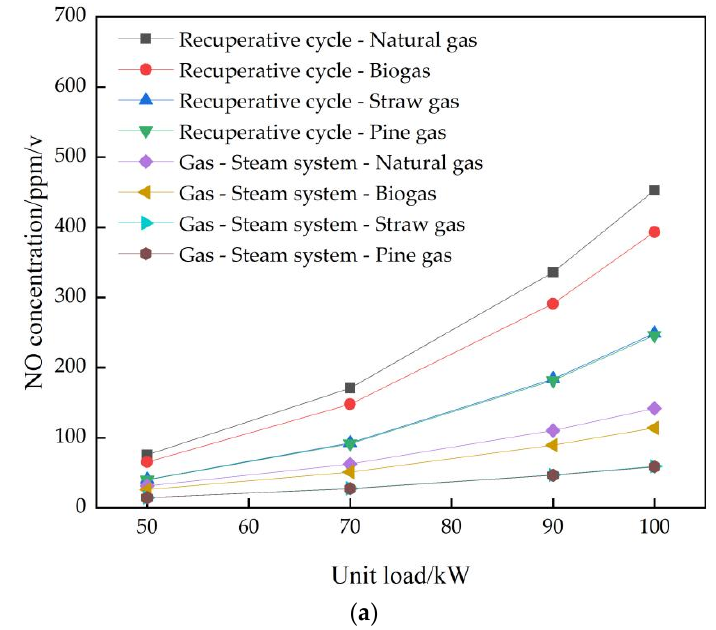
Figure 6. Partial load operation efficiency chart of gas-steam cycle.